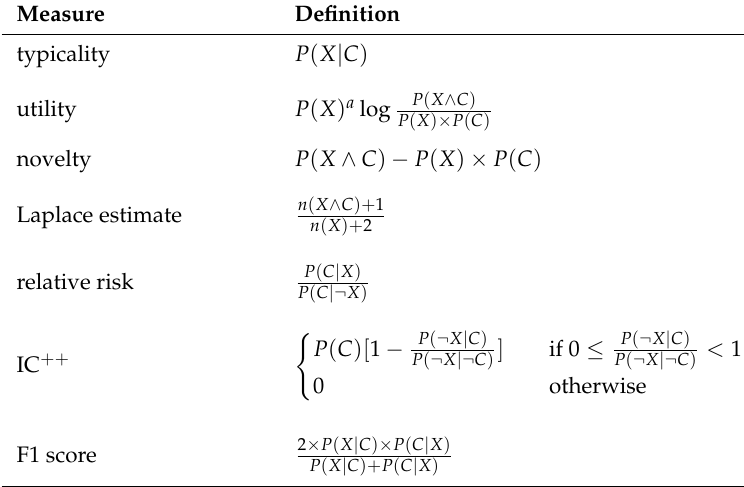
Table 1. Interestingness measures for characteristic